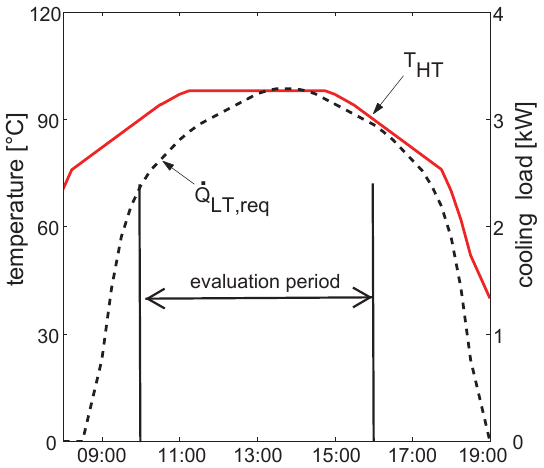
Figure 4. Hot water temperature and cooling load